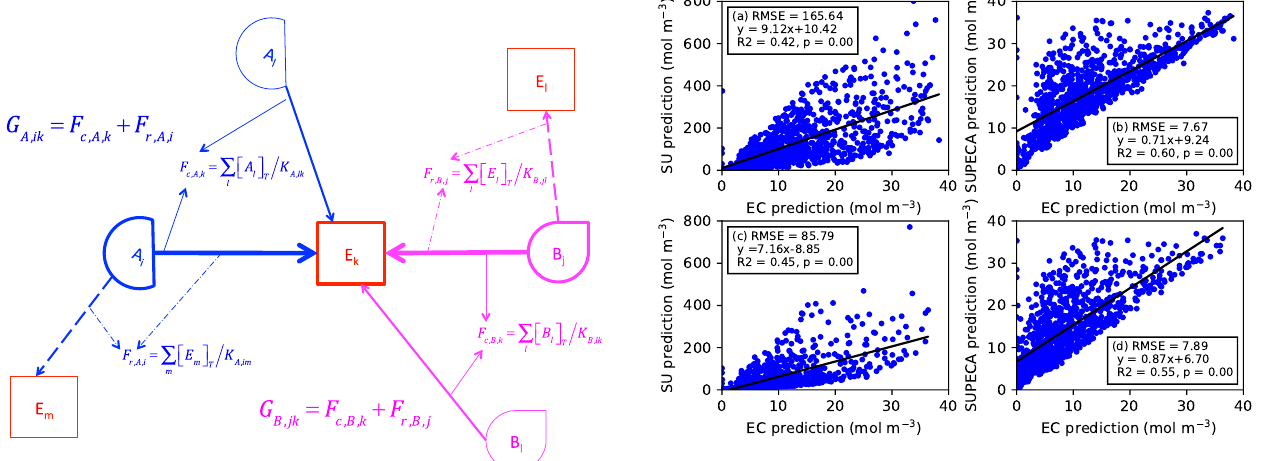
Figure 3. Benchmark of the SU (left column) and SUPECA (right column) predictions against those by the full EC formulation. We note that the y axes of the left panels are of much larger scale than those on the right. The problem is formulated in Appendix F. Pan- els (a) and (b) are for the case when M = 0; panels (c) and (d) are for uniformly distributed M > 0. The black solid lines are the lin- ear regression of SU or SUPECA predictions with respect to the EC solution, whose statistics are shown in the figure. The related distributions of parameters are in Fig. S1 of the